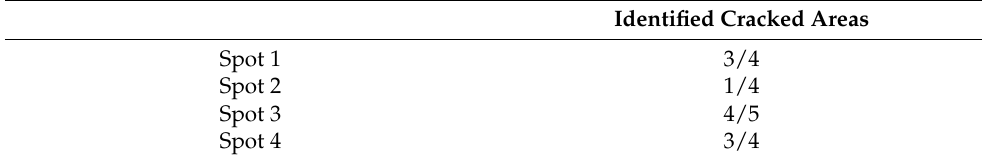
Table 1. Cracks correctly identified by the algorithm at each spot.